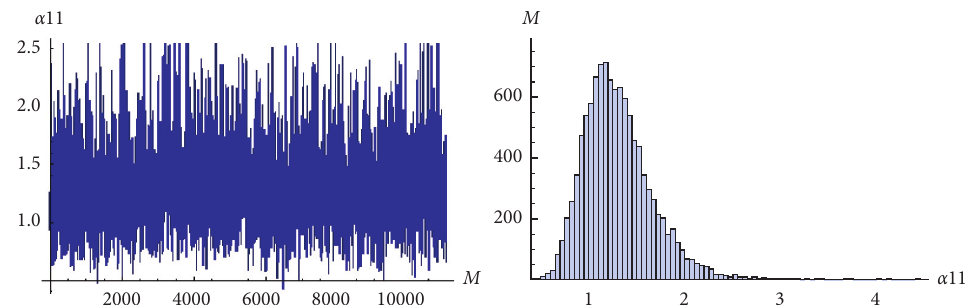
Figure 4: Simulation MCMC generated number/histogram of the parameter β